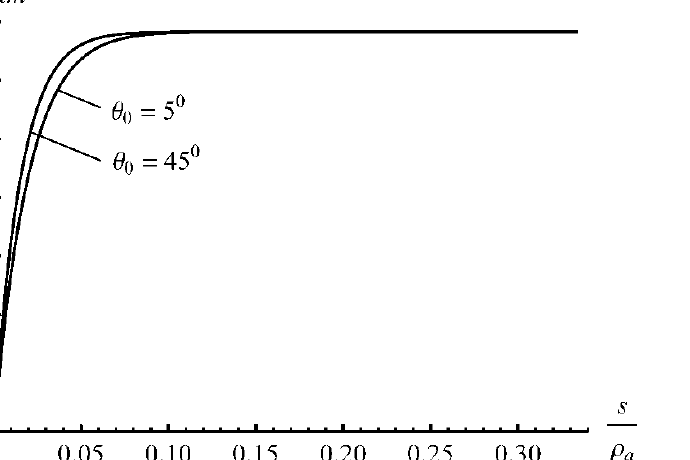
Figure 4. Thickness of the layer of intensive plastic deformation along the friction surface for the von Mises yield criterion.